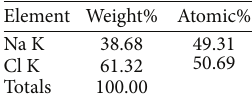
the SR/TiO 2 sample at temperatures up to 150 ∘ C for different periods of time. The superhydrophobic coating exhibited Figure 6. A high static contact angle of 160 ∘ and low